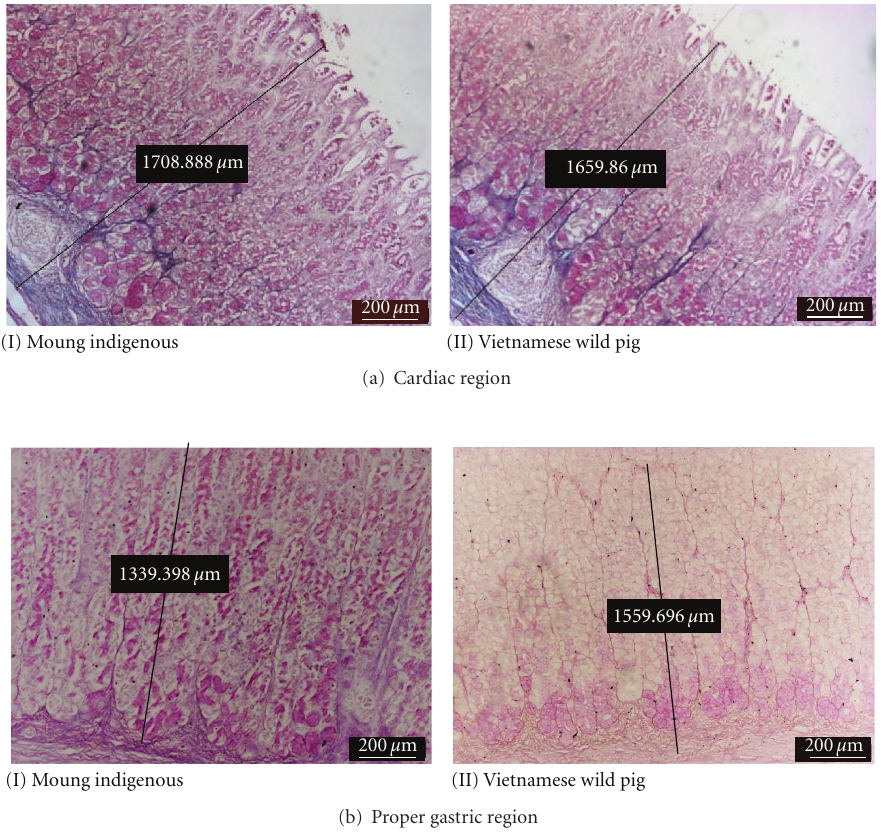
Figure 7: Photomicrograph of PAS staining showing di ff erent a ffi nity of cells towards the stain.